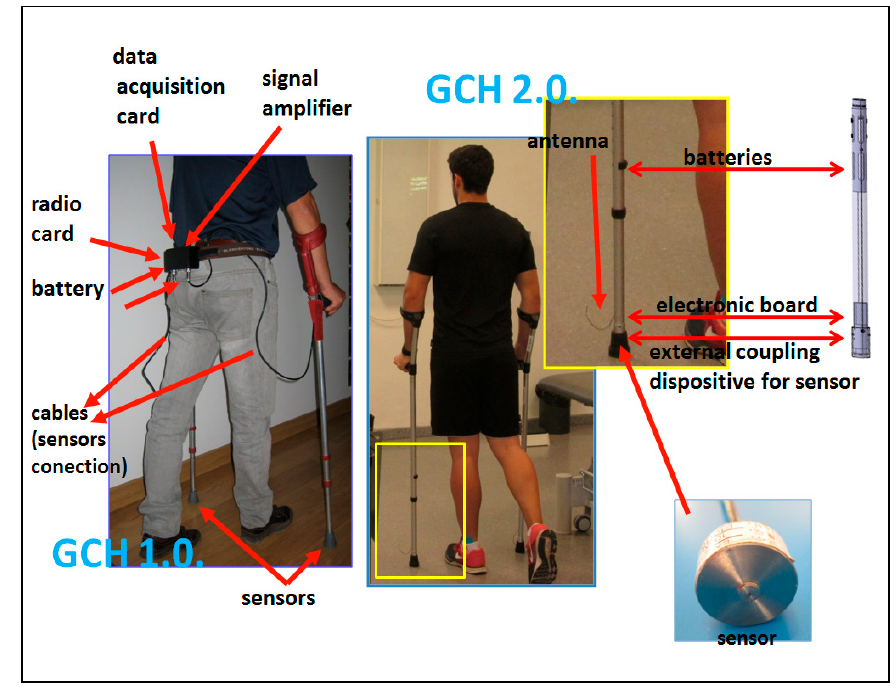
Figure 1. Comparison of GCH 1.0 and GCH 2.0.